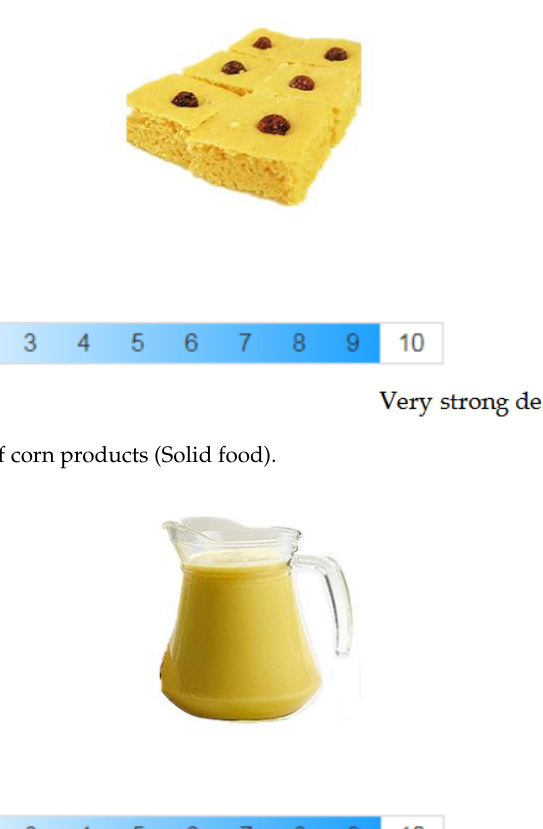
Figure A8. The picture of mango products (Liquid food).